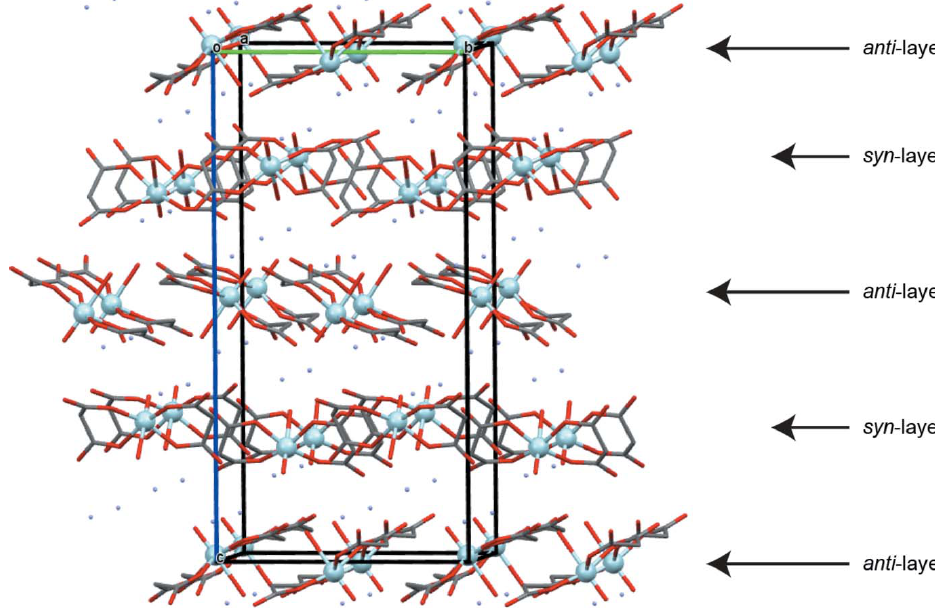
Figure 3 A packing diagram showing the alternating stacking structure. Hydrogen atoms have been omitted for clarity.